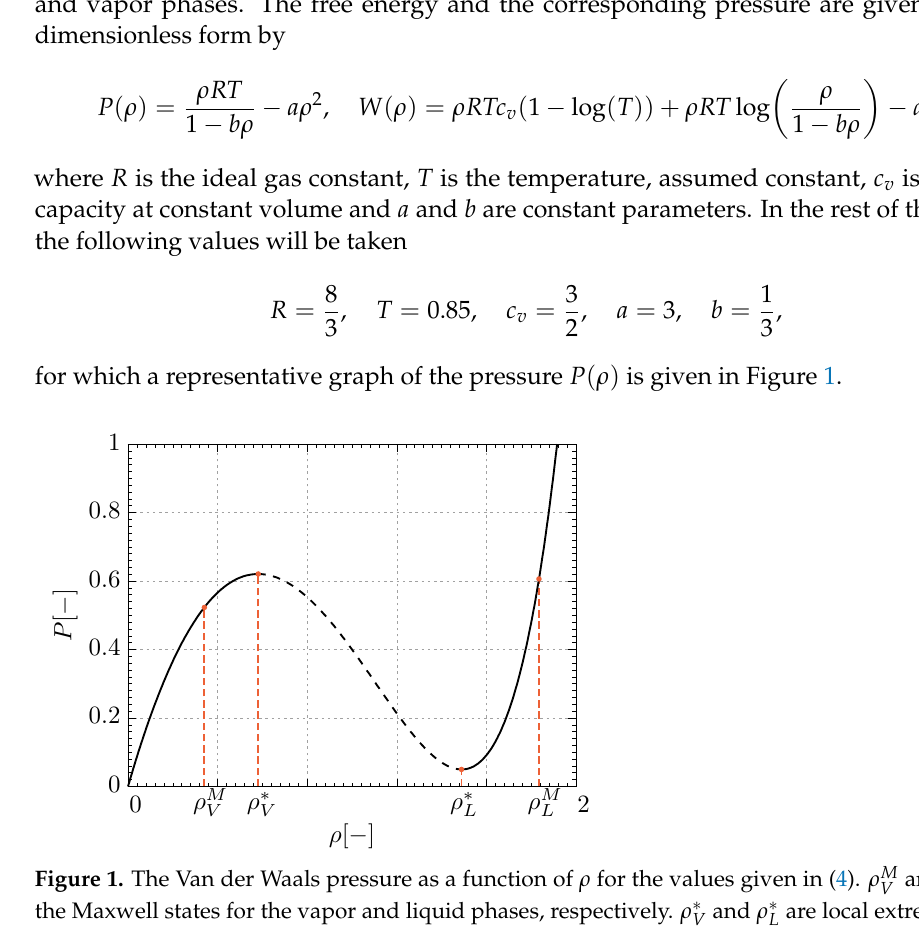
Figure 1. The Van der Waals pressure as a function of ρ for the values given in (4). ρ M the Maxwell states for the vapor and liquid phases, respectively. ρ ∗ pressure and delimit the non-convexity